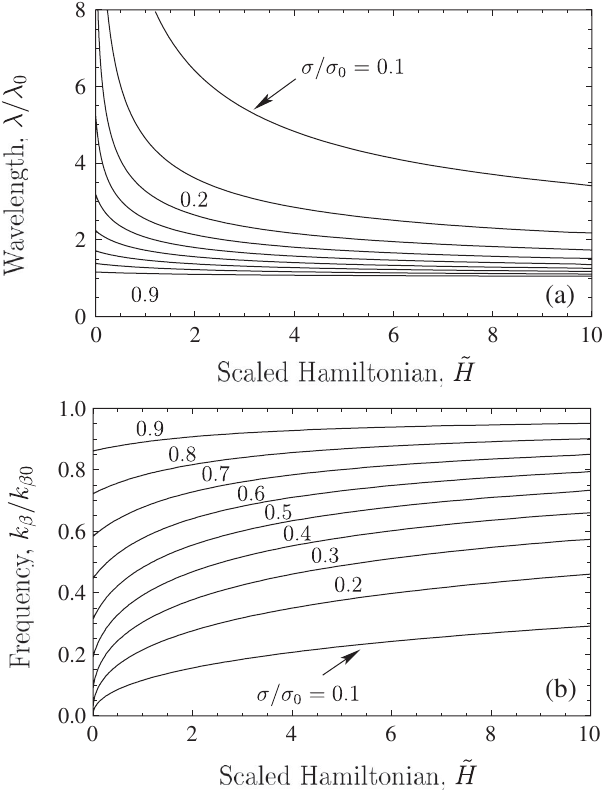
¼ 0 ¼ (cid:10) =k =(cid:10) (cid:1) (cid:1) 0 0 ¼ 0